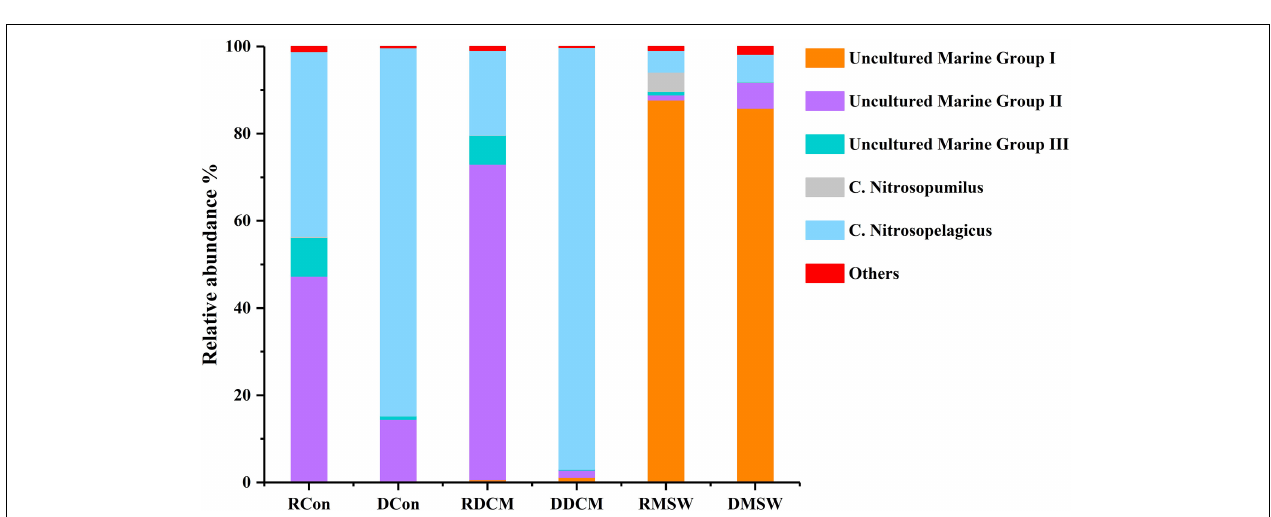
FIGURE 5 | Distributions of genus-level taxa. Bars represent the relative abundance of Illumina sequences representative of each genus. Bacterial taxa represented by less than 1% of reads are pooled as “others.” “Uncultured” means that the specific archaeal taxa cannot be classified at the genus level. The R before the sample group name represents RNA (active), and D stands for DNA (total). The proportion of each sequence in DNA samples is the mean value of duplicate